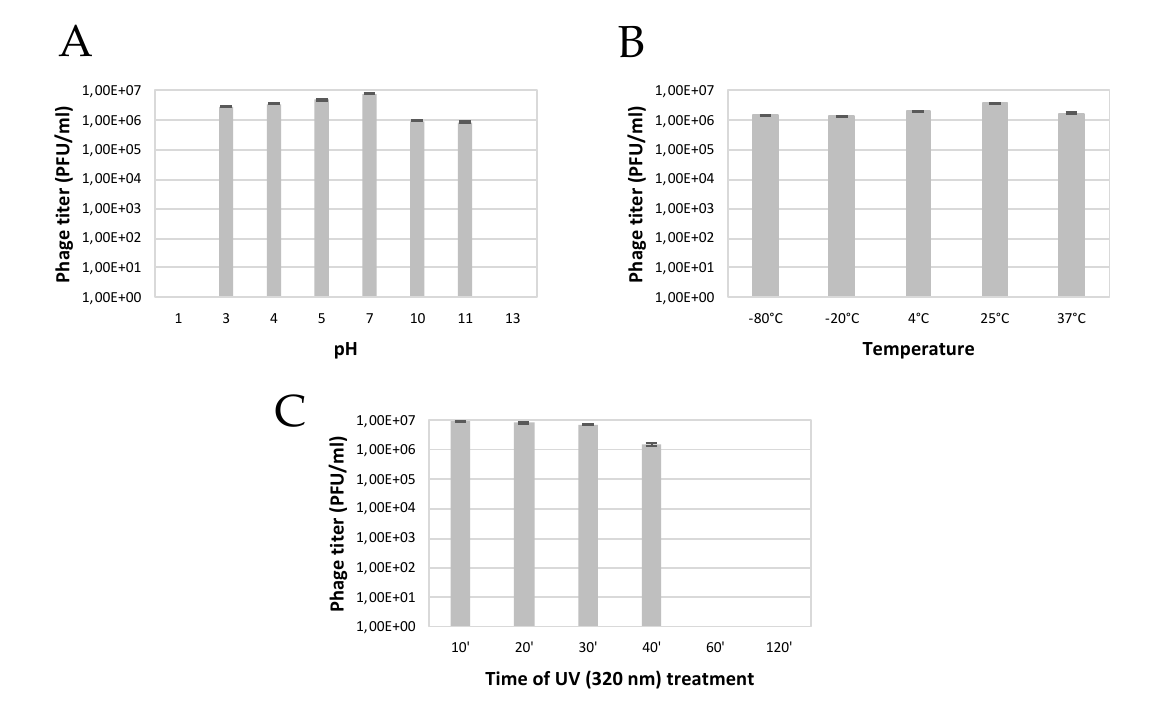
Figure 2. Stability of SoKa under different environmental conditions. ( A ) Effects of pH changes. ( B ) Activity of SoKa at different temperatures. ( C ) Effect of UV treatment on the stability of the SoKa phage. The error bars show the standard error of the mean.